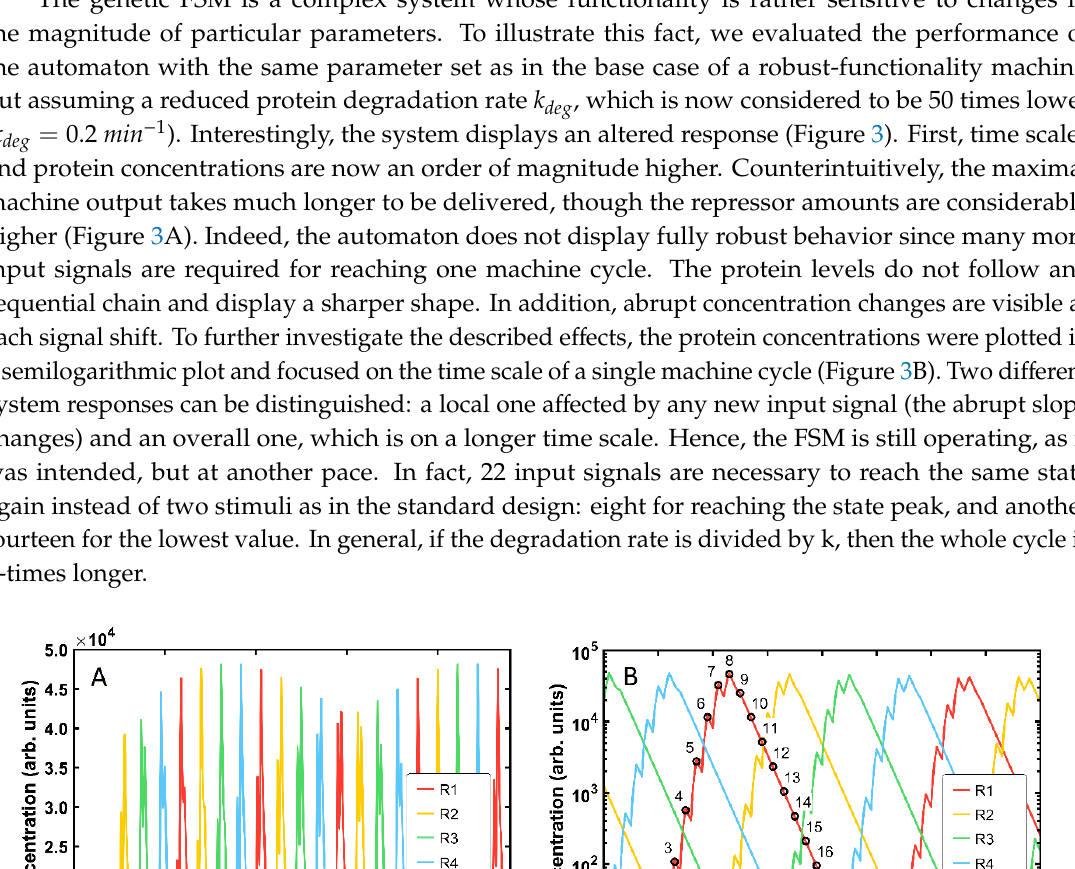
Figure 4. Time evolution of the concentration of each repressor protein R n for the same parameter set as the base simulation except for 𝐾𝐾 𝑆𝑆𝑆𝑆 = 10, 𝐾𝐾 𝑆𝑆𝑆𝑆 = 165 . Signal depicted in black.